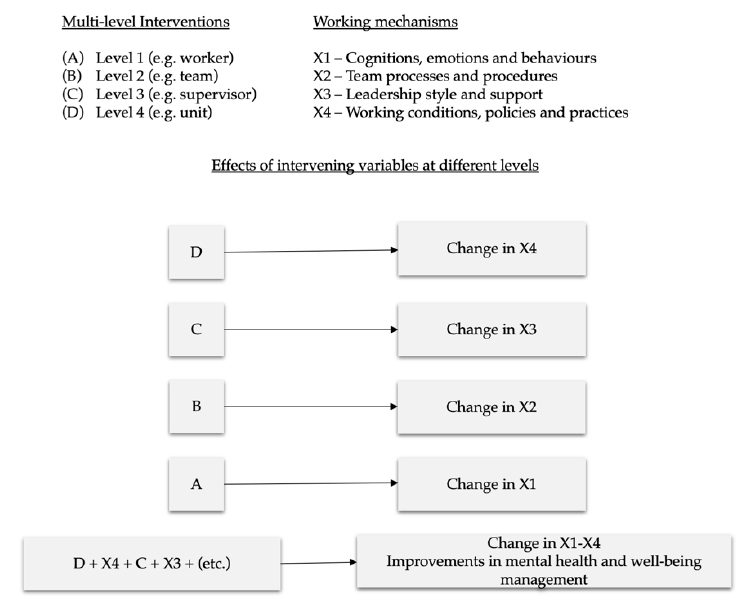
Figure 2. H-WORK design for assessing multilevel interventions .